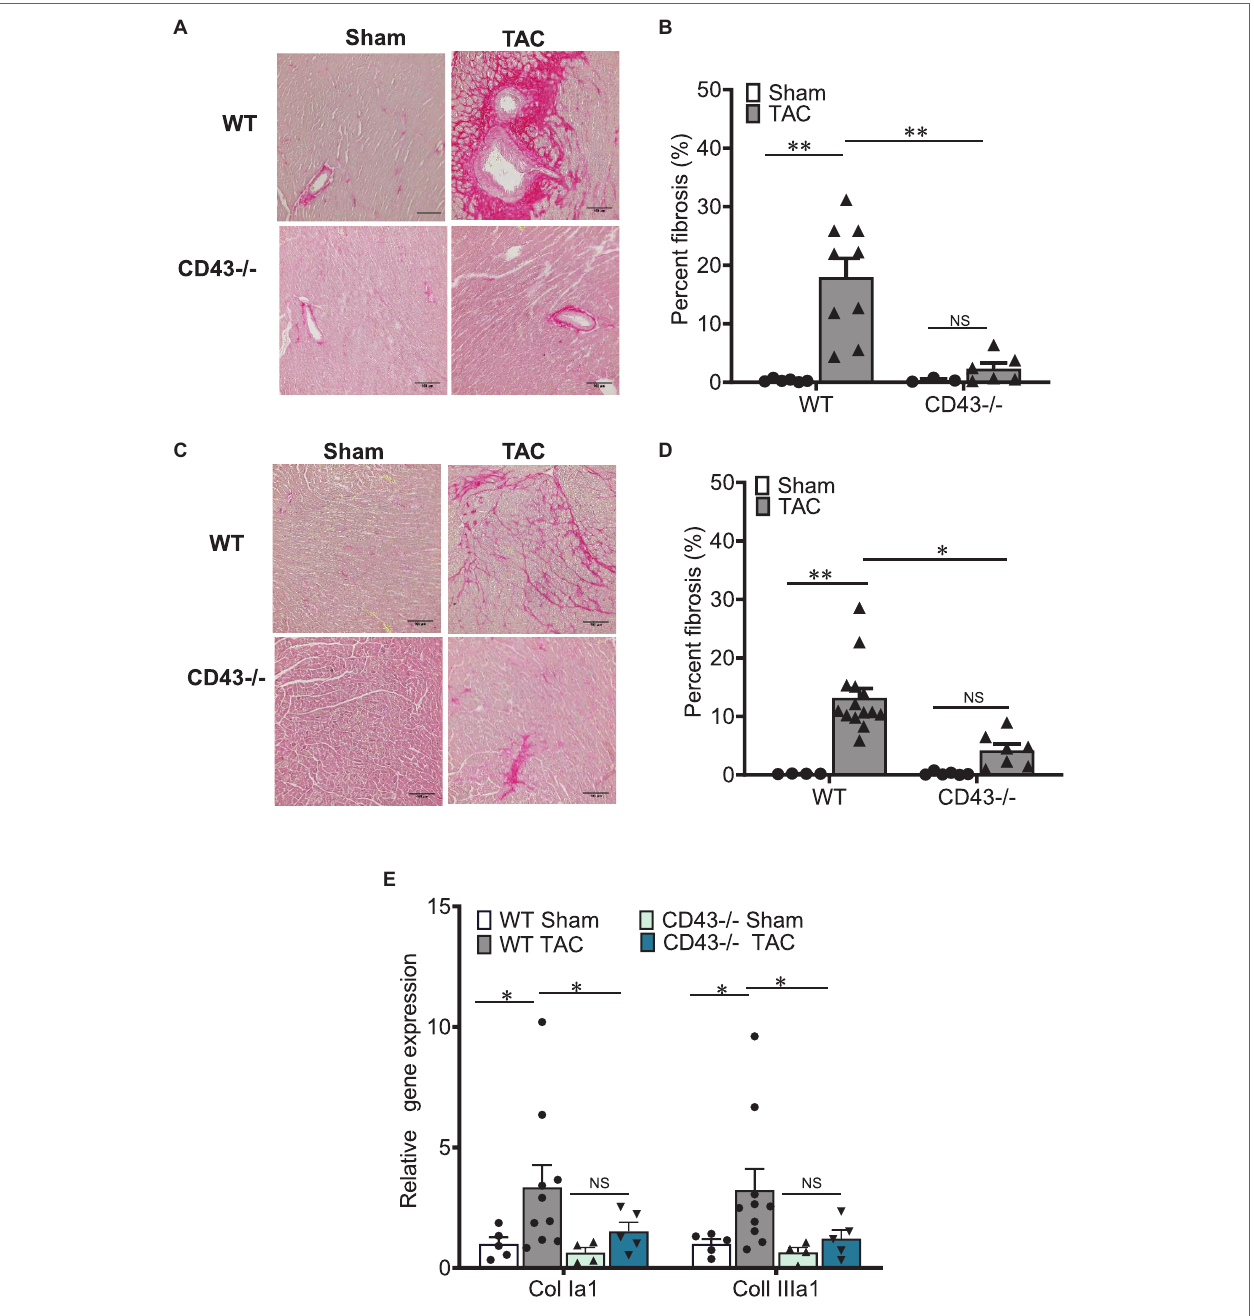
FIGURE 2 | CD43 − / − develop less fibrosis in the left ventricle (LV) in response to TAC as compared to WT mice. Representative images of perivascular (A) and interstitial (C) fibrosis after 4 weeks of TAC, as demonstrated by picrosirius red staining. Scale bars, 100 μ m. Quantification of perivascular (B) and interstitial fibrosis (D) . (E) Quantification of Collagen Ia1 and Collagen IIIa1 gene expression from heart lysates. * p ≤ 0.05; and ** p ≤